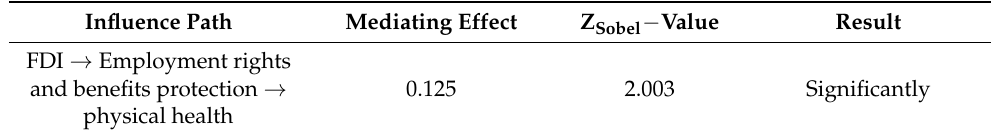
Table 5. The results of the mediation effect